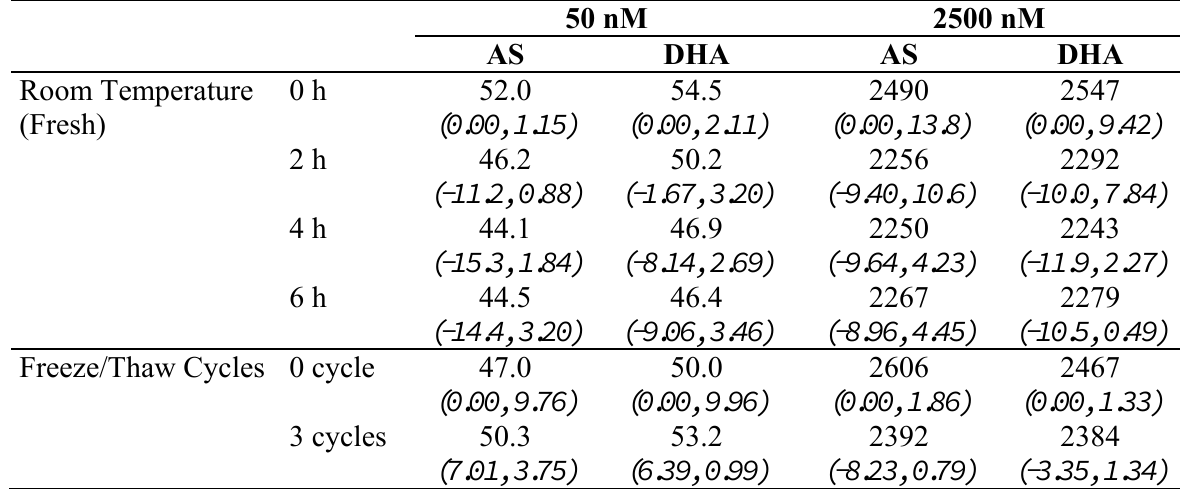
Table 3. Stability tests of AS and DHA in plasma ( a ) at room-temperature and after three cycles of freezing/thawing, and ( b ) at long-term storage temperature ( - 80